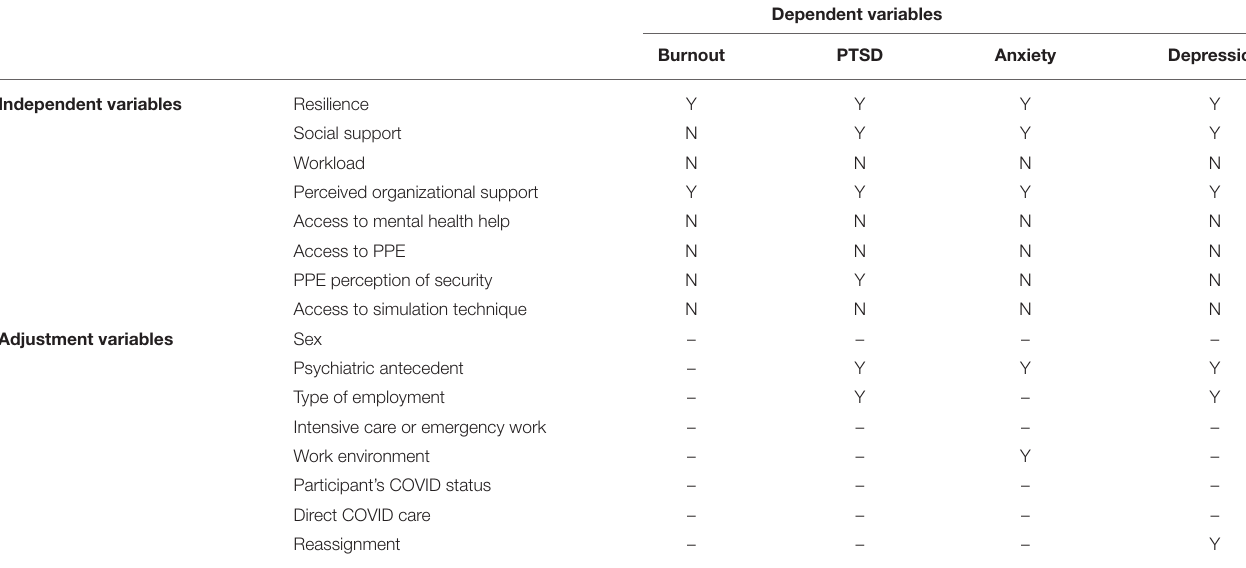
TABLE 7 | Summary table of factors significantly associated with burnout, post-traumatic stress disorder, anxiety and